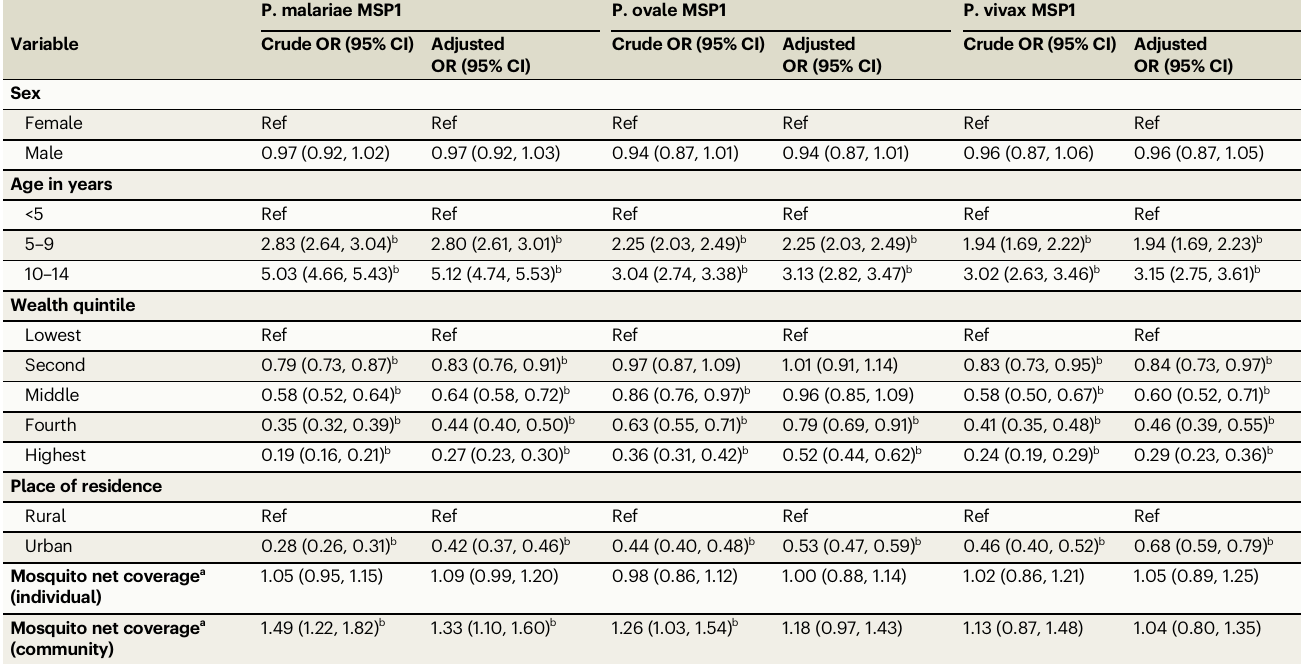
Table 3 | Crude and adjusted odds ratio estimates for risk factors for IgG seropositivity to PmMSP1, PoMSP1, and PvMSP1 antigens by demographic, socioeconomic, and behavioral risk